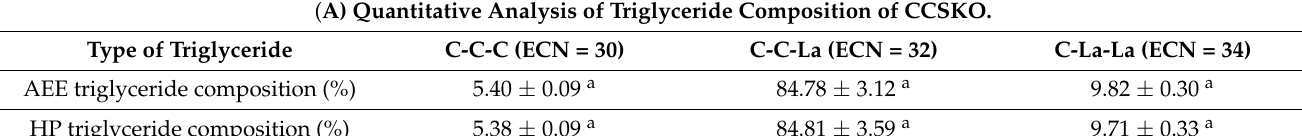
Table 2. Quantitative and qualitative analysis of triglyceride composition of CCSKO. ( A) Quantitative Analysis of Triglyceride Composition of